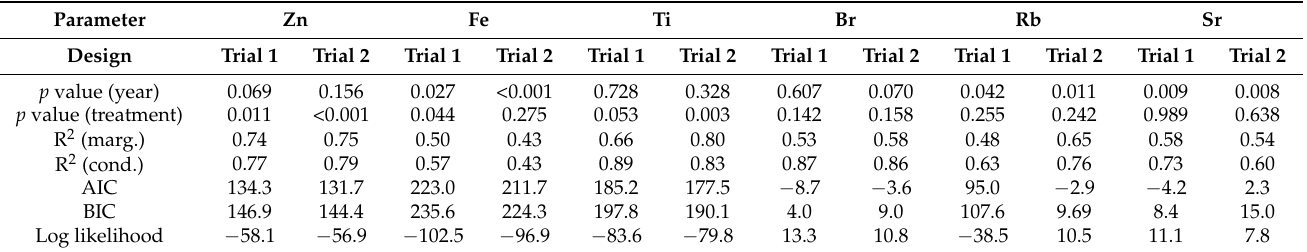
Table 3. Summary data of the linear mixed model ANOVA for microelements in oat grains produced during